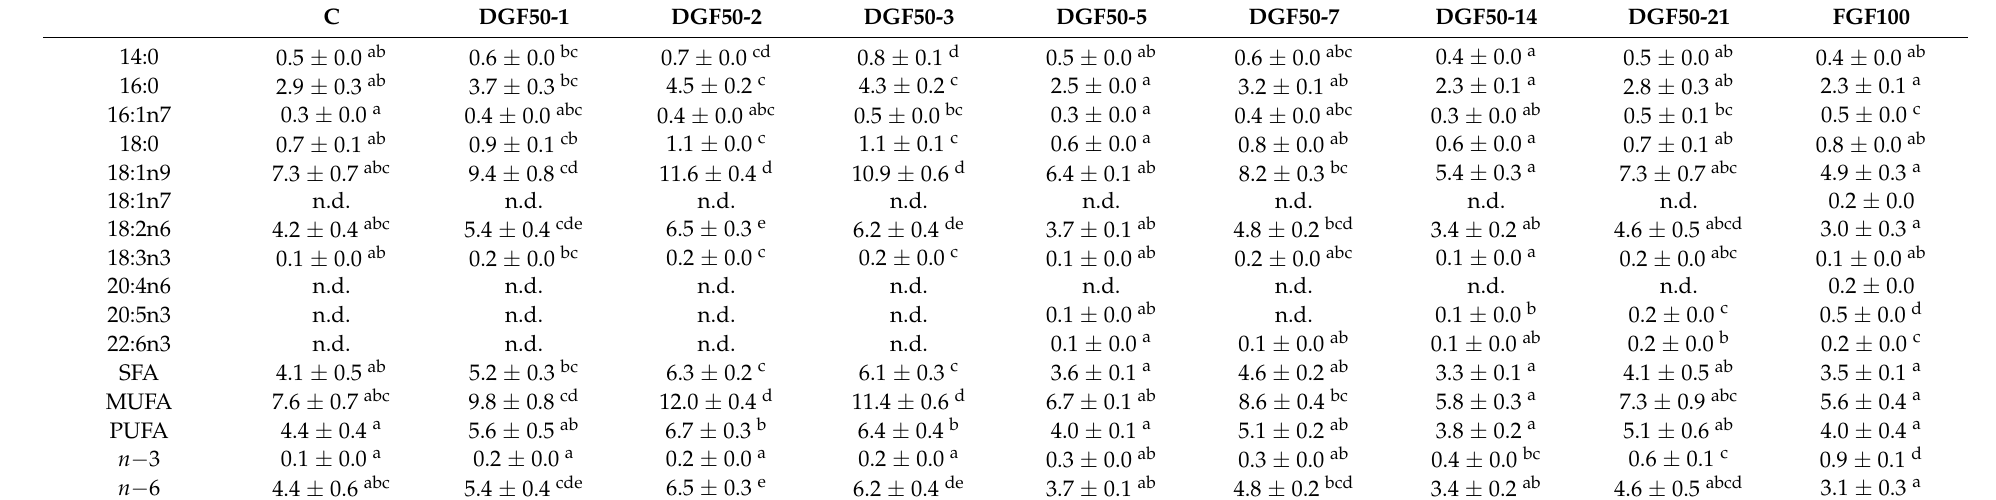
Table 4. Fatty acid profiles (g FA/100 g dry weight) of Tenebrio molitor larvae fed with fish-based diets.